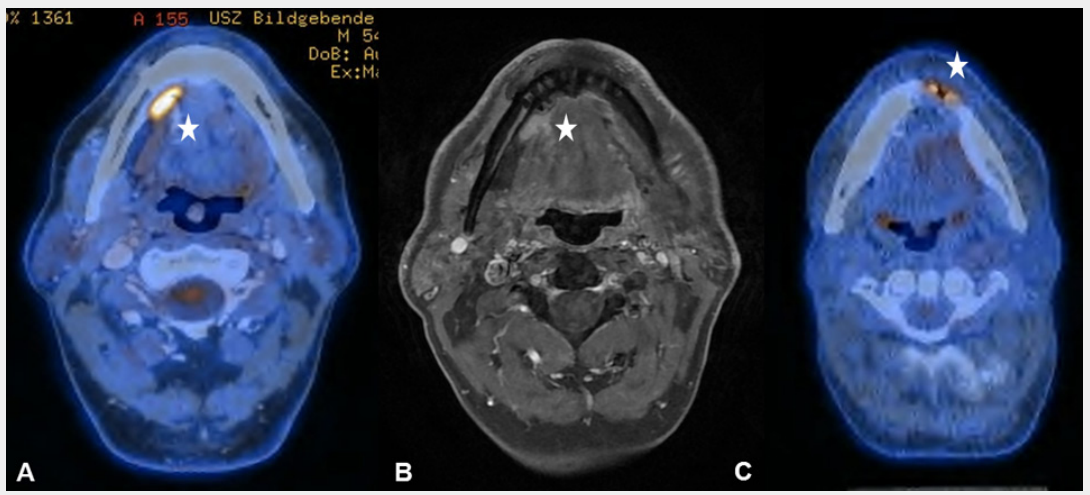
Figure 5 (A) Increased focal uptake in the right submandibular gland in a 54-year old patient, who underwent surgical resection and reconstruction with a pedicled flap owing to a lateral tongue carcinoma. (B) The corresponding T1–weighted magnetic resonance imaging helps to delineate the shifted submandibular gland due to the pectoralis maior myocutaneous flap. (C) Sixty-six year old patient after segmental mandibular resection, mandibular reconstruction and implantation of dental implants due to an anterior floor-of-mouth